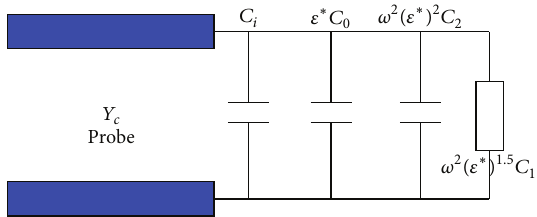
Figure 2: The equivalent circuit of admittance model for a coaxial open ended